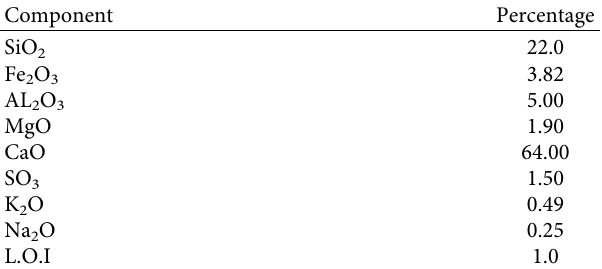
Figure 1: Grading of aggregate. Table 2: Chemical analysis of cement.